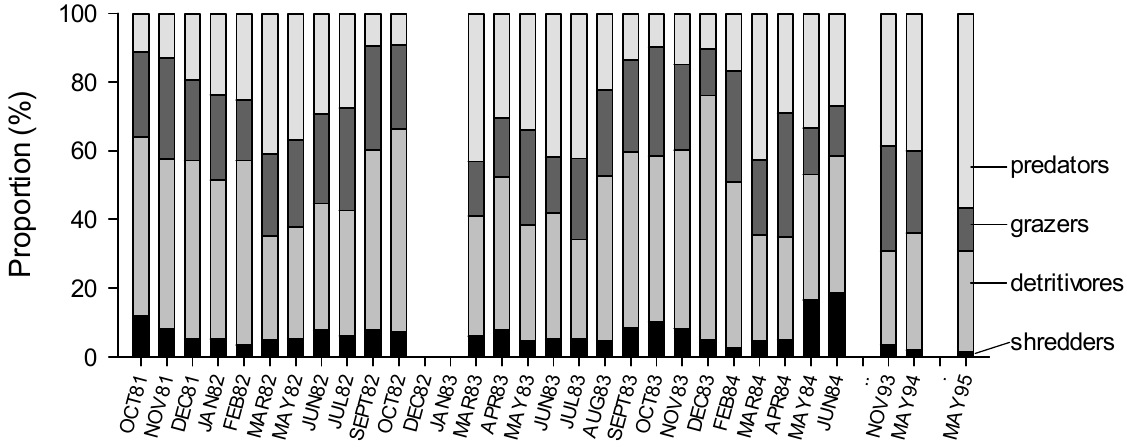
Figure 5. Proportional trophic composition of monthly samples. “Grazers” include scrapers and grazers; “detritivores” are fine-particle collectors, gatherers and filterers; “shredders” are coarse-particle consumers; “predators” include predaceous filterers.